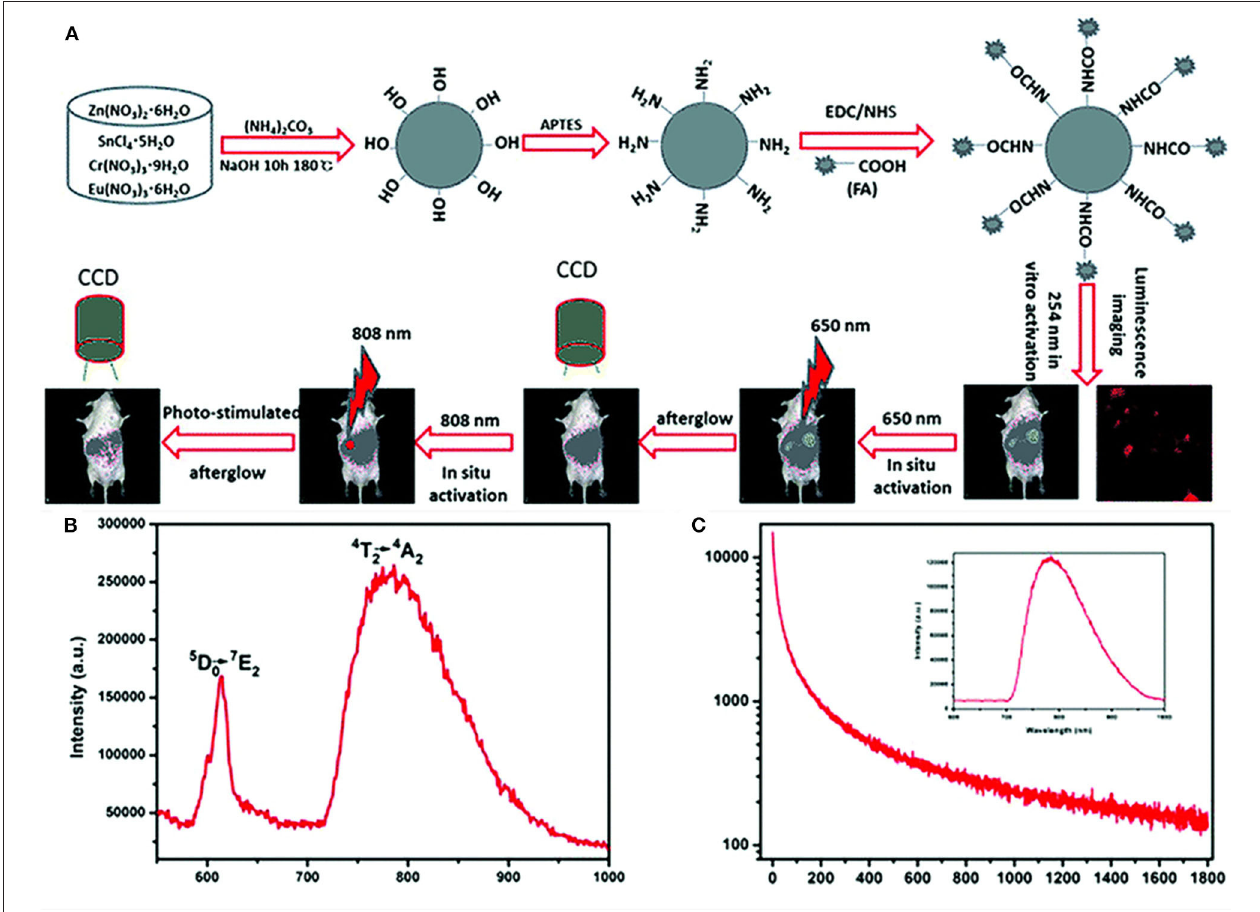
FIGURE 1 | (A) Schematic diagram of the synthesis and bioimaging applications of the ZnSn 2 O 4 :Cr,Eu PLPs, (B) emission spectrum of the PLPs of excitation at 254nm, (C) decay curve of the PLPs of excitation at 254nm and the inset is PersL spectrum. Reproduced from a literature Li et al. (2017) with permission from Royal Society of